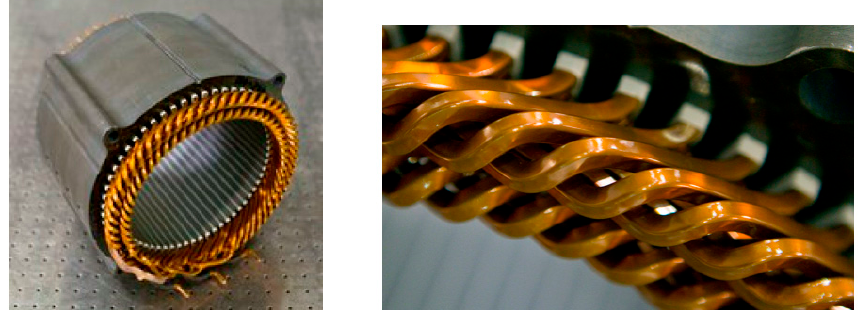
Figure 1. Motor GM-85KW for the Chevrolet Spark–Windings overhang.